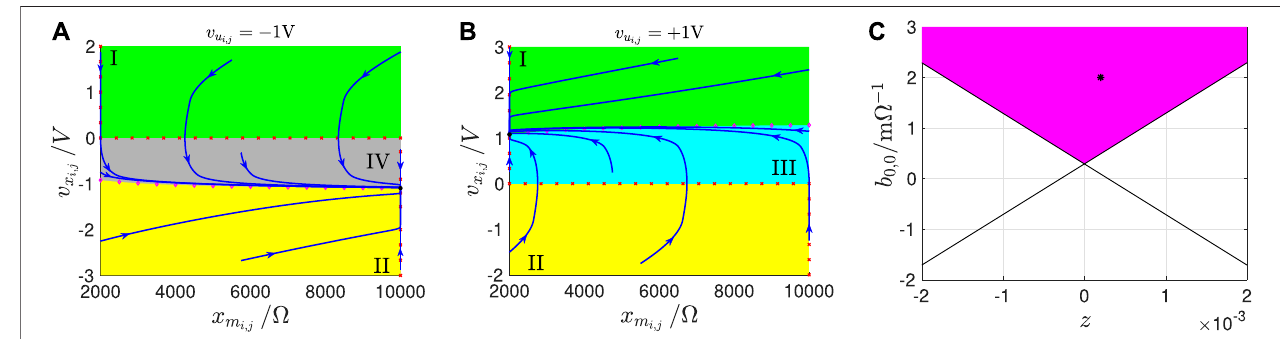
FIGURE17|(A , B) SDPoftheprocessingelement C ( i , j ) forthestorageofthenegative(positive)onevalue,assignedtoitsinputvoltage v u (black) pixel at row i and column j of a given input binary image, in the form of off (on) resistance x off ( x on ) into its memristor M x monostable, featuring a single equilibrium, attracting all phase-plane trajectories, and lying in the negative (positive) saturation region, along the vertical line crossing the – axisattheupper(lower)boundofthememristorstateexistencedomain D ,asexpectedfromrule1(2)of Table5 . (C) Graphicaldeterminationofthe horizontal x m i , j solutions of the non-redundant inequality pair Eq. 62 , descending from the application of the proposed DRM 2 -centered system-theoretic bio-inspired array design method to the model Eqs. 18 , 19 of the processing element C ( i , j ) , in each region of the standard nonlinearity (3), as discussed in detail in the text, and illustrated graphically in Figure 14 , for the synthesis of an ad-hoc family of STORE M-CNN cell SDPs. The magenta region constitutes the domain of the two-dimensional z – b 0 , 0 parameter space, which hosts all the admissible solutions of the system of inequalities 62 , which, taking into account Table 3 , and assigning the values of 5 · 10 − 3 Ω − 1 , and of 20 · 10 − 4 Ω − 1 , to a 0 , 0 , and G x , respectively, feature the analytical expressions b 0 , 0 > ( 2 . 9 · 10 − 4 + (−) z ) Ω − 1 , with the positive (negative) polarity option de fi ning a rule 1 (2)-based constraint. The particular cell DRM 2 , foliating in the SDPs of plots (A) and (B) , associated to a nonzero offset current i w admitting a GAS equilibrium ( x